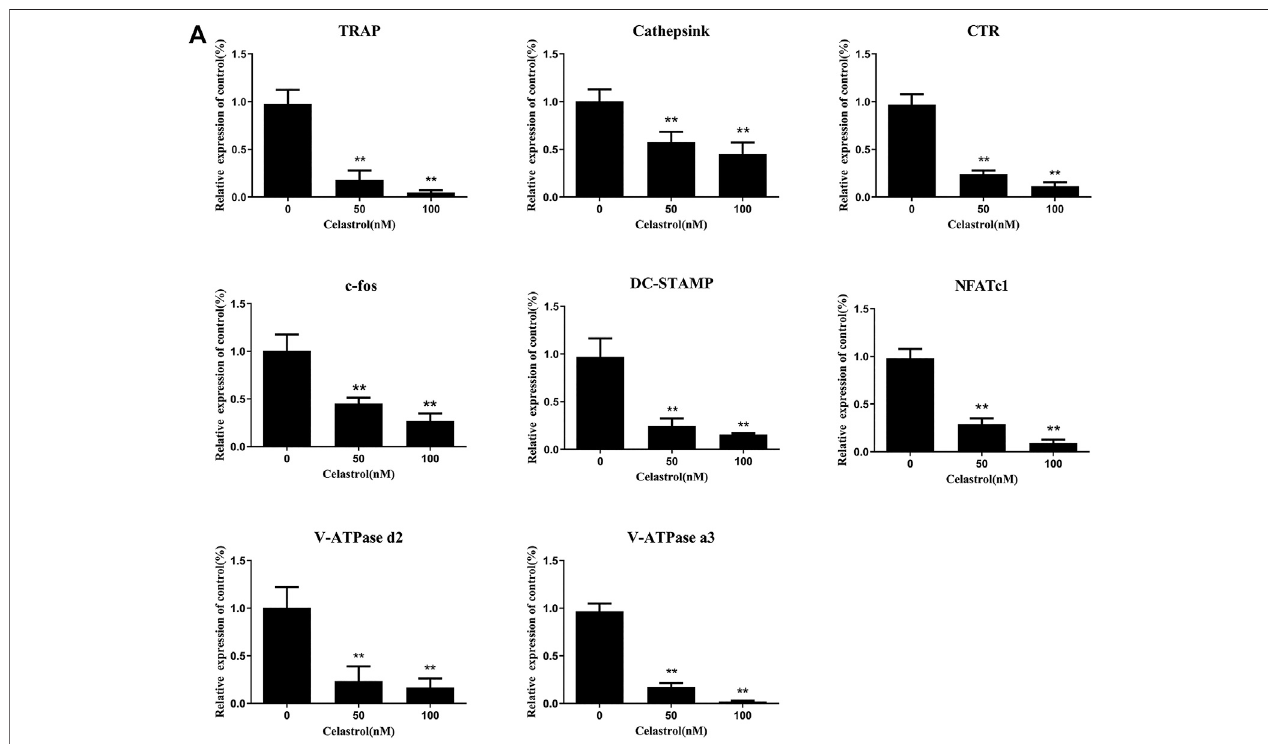
FIGURE 3 | (A) Celastrol inhibited the RANKL-induced expression of osteoclast-speci fi c genes. Q-PCR was applied on RNA extracted from RAW264.7 cells stimulated with 50 ng/ml RANKL and treated with 0, 25, 50, and 100 nM celastrol for 5 days. The expression levels of TRAP, Cathepsink, CTR, c-fos, DC-STAMP, NFATc1, V-ATPase d2, and V-ATPase a3 were normalized to GAPDH. All experiments were carried out three times, and all data are showed as the means ± SD; * p < 0.05, ** p < 0.01.